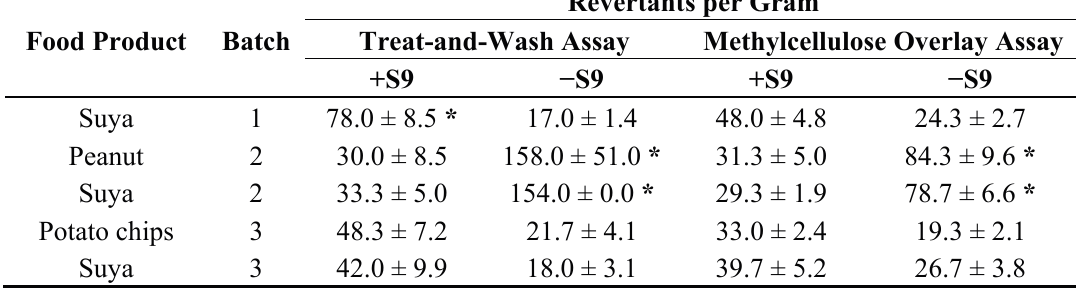
Table 5. Number of revertants in the treat-and-wash as well as methylcellulose overlay assays generated by the highest concentrations (1.0 per g of food sample) of food extracts showing mutagenic potential on Salmonella TA 98 (mean ± SD) in the standard plate incorporation